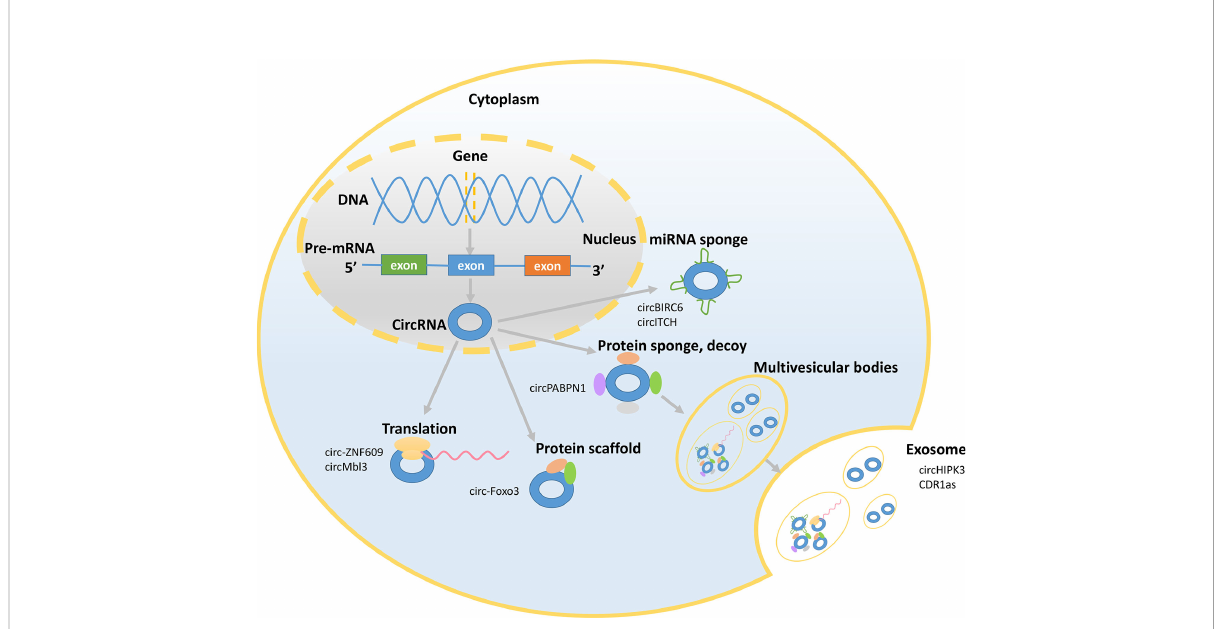
FIGURE 2 Mechanisms underlying circRNA functions. The picture shows that circRNAs exert their functions in the nucleus and cytoplasm and presents some representative circRNAs. CircRNAs can act as miRNA sponges and bind to RNA-binding proteins (RBPs) and can be translated and sorted to the